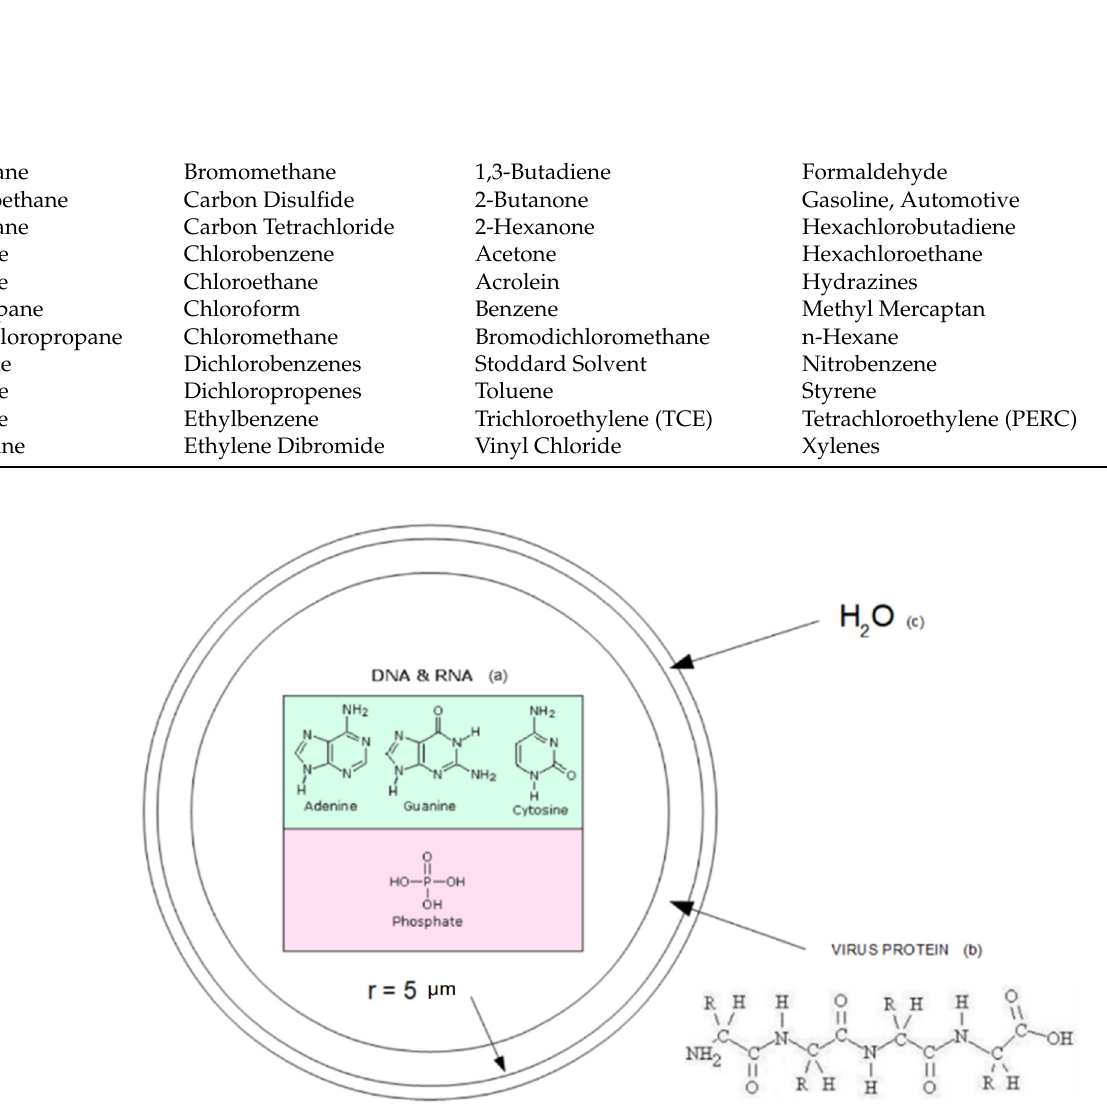
Figure 1. Virion particle modeling.